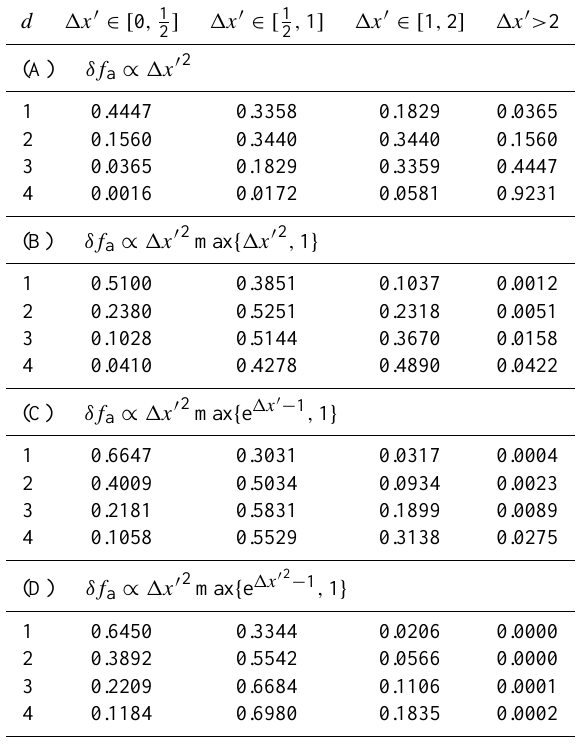
Table 1. Relative contributions of different regions in 1x 0 -space to the least-squares solution for different approximation error models, assuming uniform coverage. See the text for an